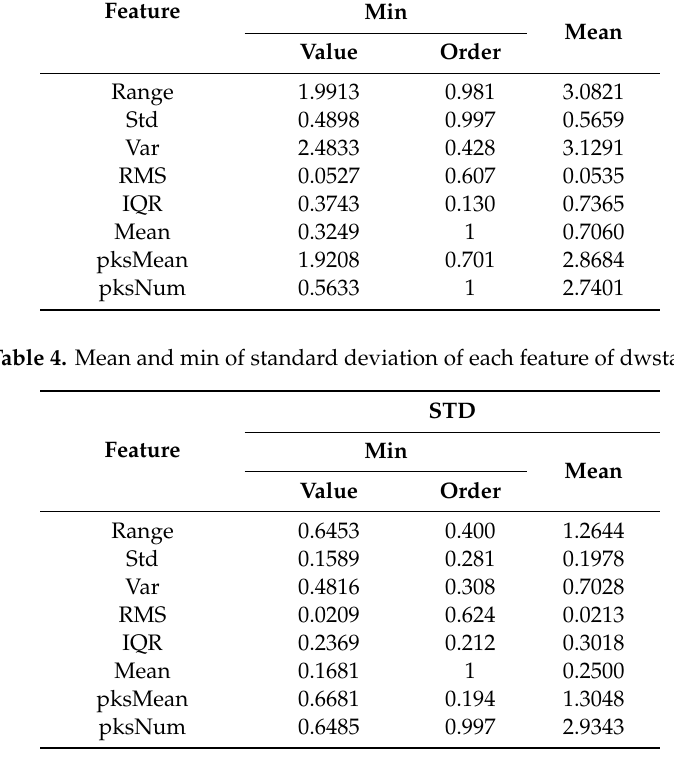
Table 5. Mean and min of standard deviation of each feature of